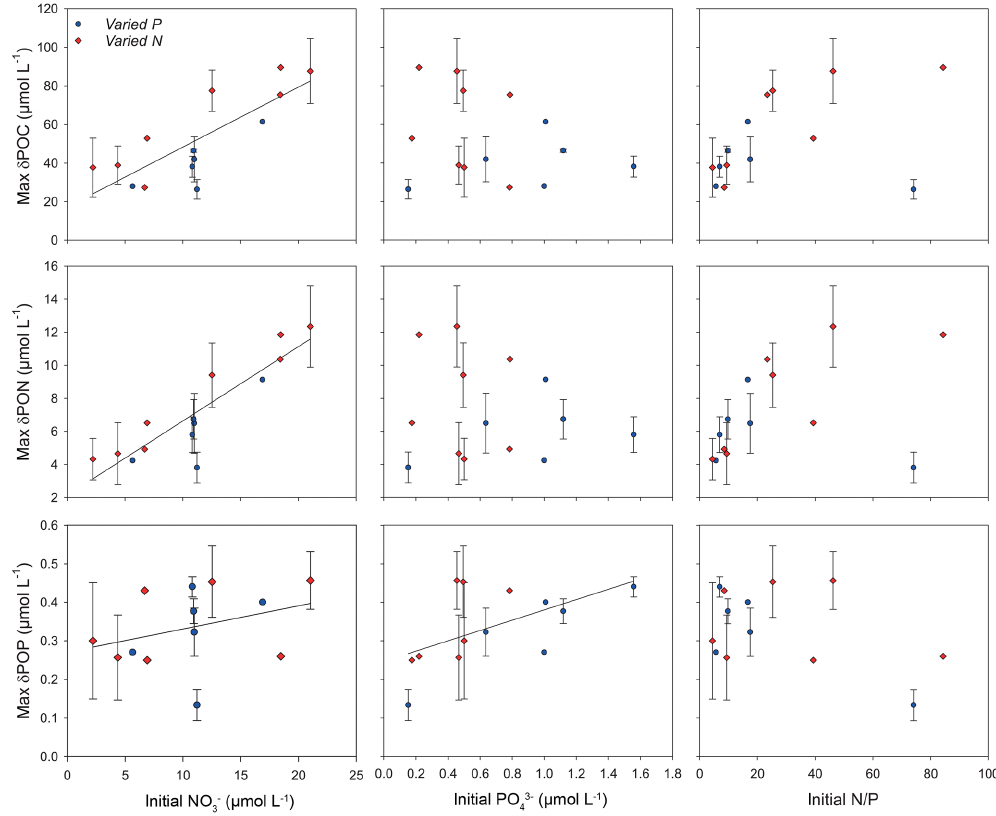
Figure 3. Maximum POC, PON and POP accumulation as a function of the initial supply of NO − defined as peak POM concentration subtracted by the initial (day 1) POM concentration. Treatments in varied P are depicted as blue circles; treatments in varied N are depicted as red diamonds. Error bars denote the standard deviation of replicated ( n = 3) treatments. Regression lines (continuous lines) indicate significant linear correlations between the initial nutrient supply and POM